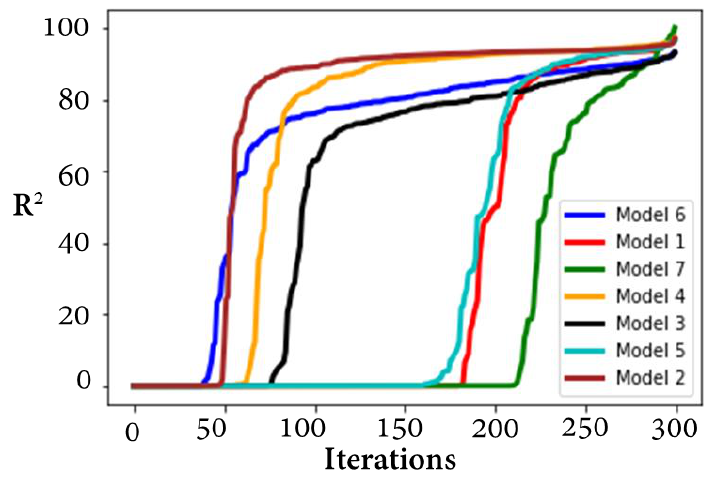
Figure 9. Illustration of the developed hyper-parameters tuning models. Table 2. An overview of the feature engineering